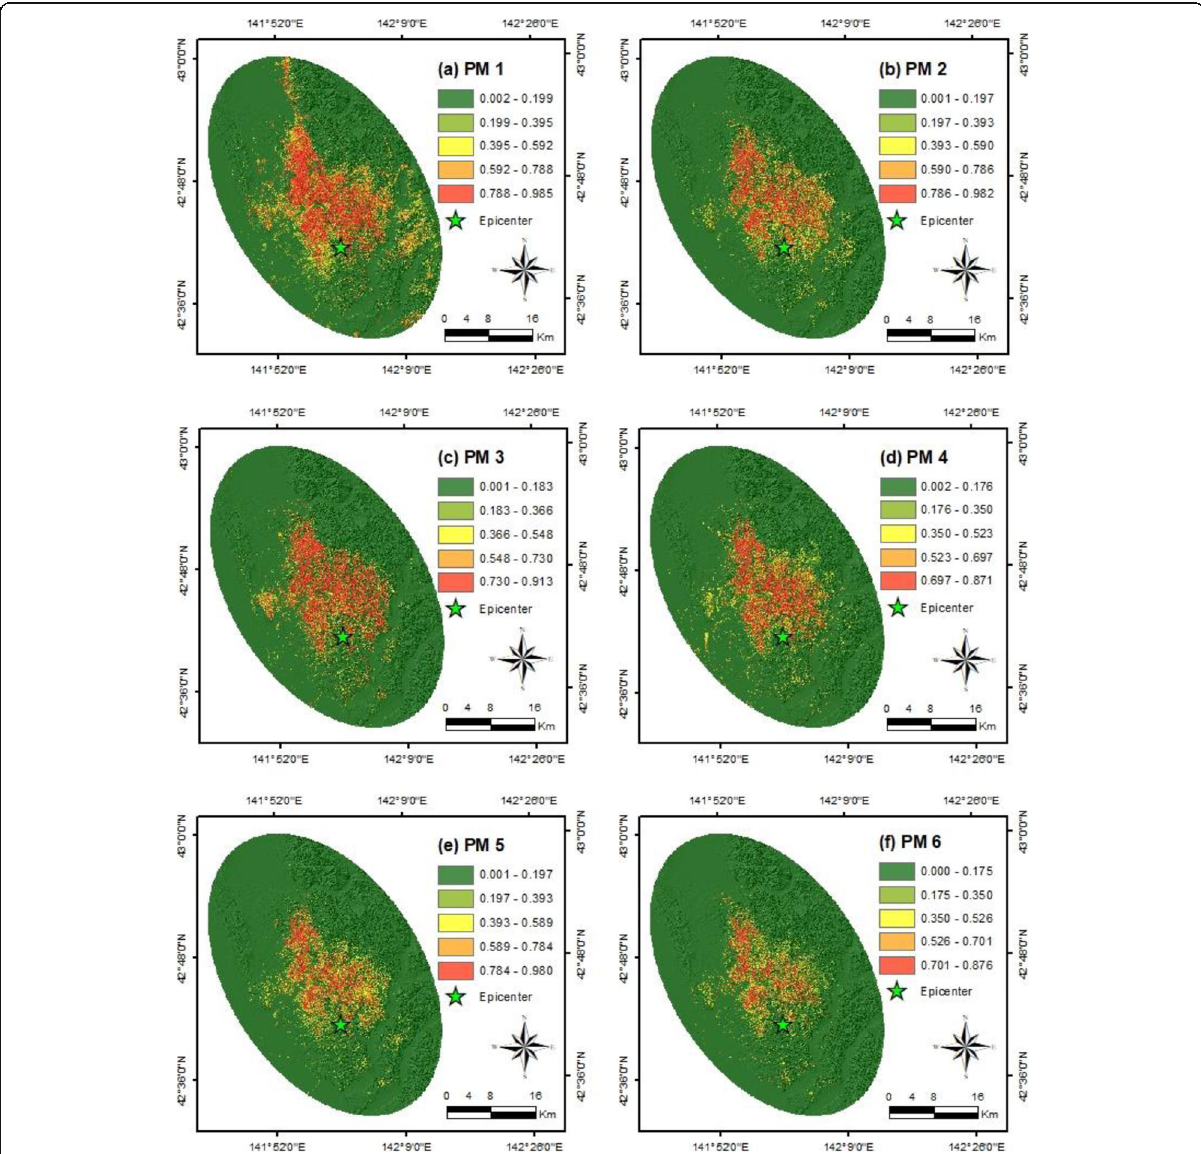
Fig. 5 Landslide susceptibility assessment on sampling strategies of non-landslide points randomly generated in the combination zone including plain and mountain (PM): a PM 1, b PM 2, c PM 3, d PM 4, e PM 5, and f PM